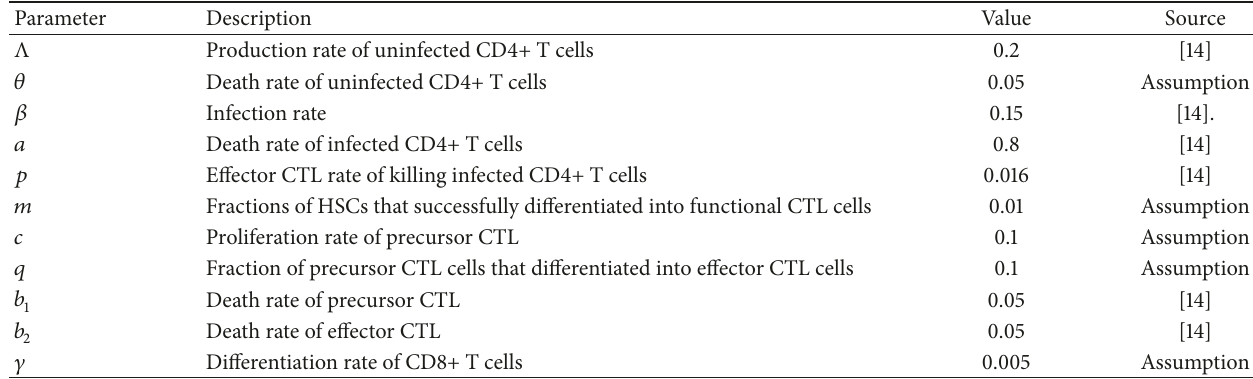
Table 4: Parameters value of the